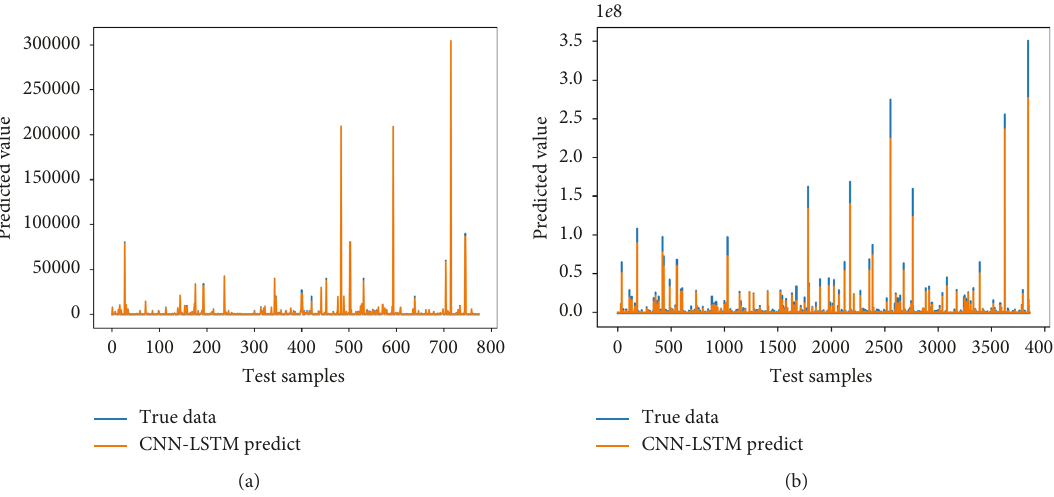
Figure 13: Testing performance of CNN-LSTM on (a) UCI seismic bumps and (b) AAIA ′ 16 seismic.